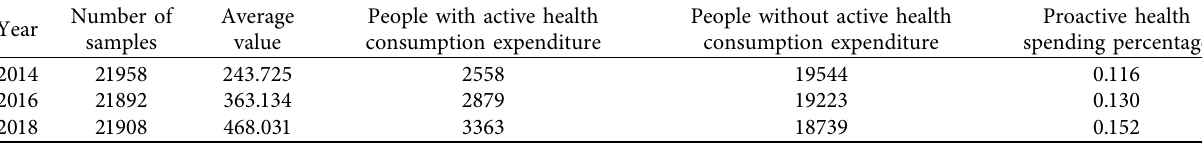
Table 1: Active health consumption expenditure of residents and the number of